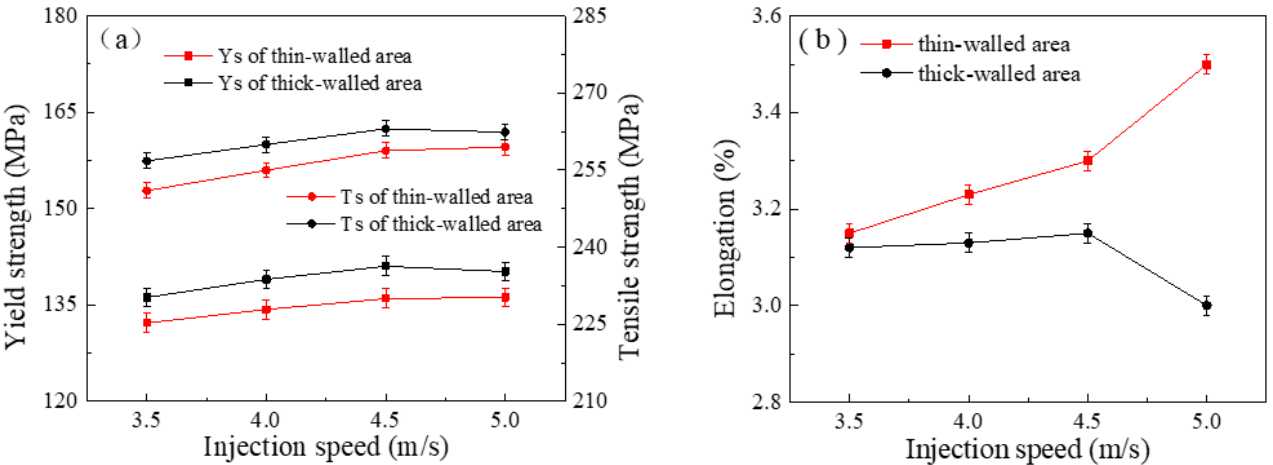
Figure 2. Mechanical properties: ( a ) Ys and Ts, ( b ) elongation of castings with different wall thick- nesses under different injection speeds.